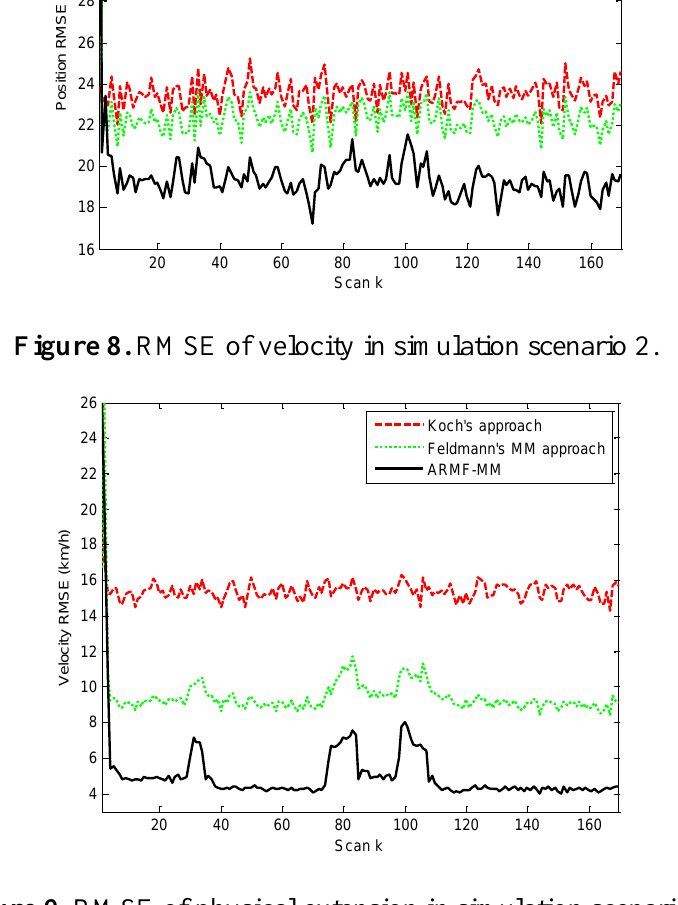
Figure 9. RMSE of physical extension in simulation scenario